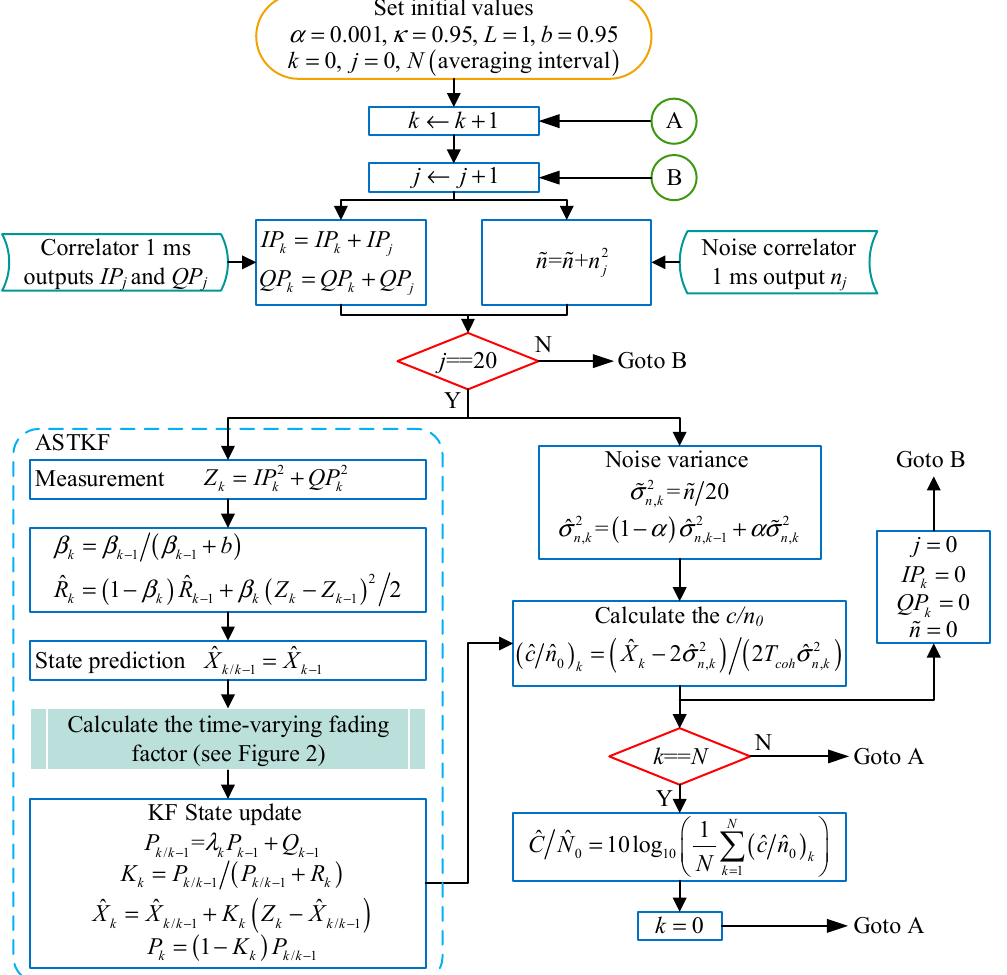
Figure 3. Summary of the adaptive strong tracking Kalman filter (ASTKF) carrier-to-noise ratio ( C / N 0 ) estimation algorithm.